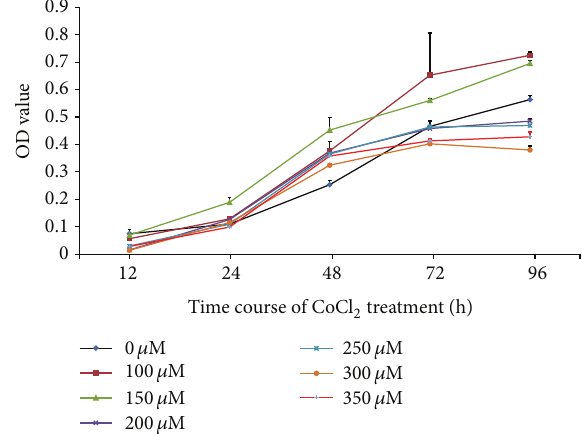
Figure 2: Growth curve of human RMECs treated with various concentration of CoCl 2